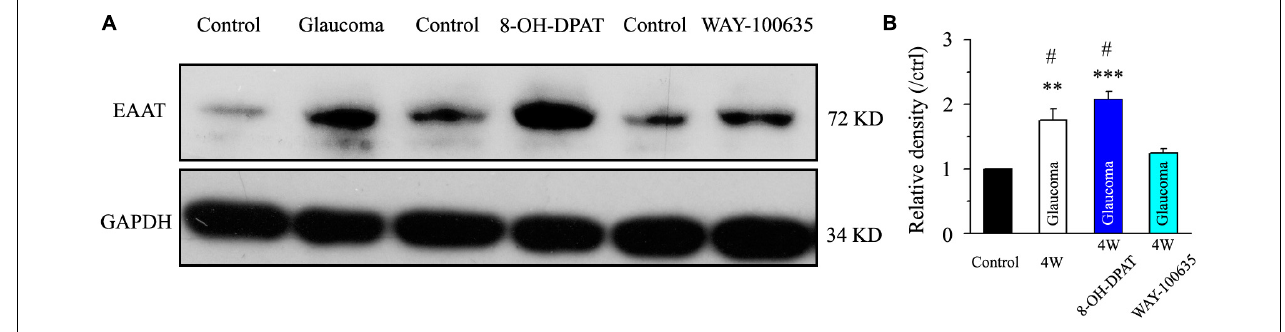
FIGURE 2 | Chronic ocular hypertension and 8-OH-DPAT upregulated EAAT2 expression in the rat retina, but this effect was reversed by WAY-100635. (A) Representative western blot of EAAT2 expression in control and glaucomatous retinas 4 weeks after EVC and in glaucoma 4W + 8-OH-DPAT retinas and glaucoma 4W + WAY-100635 retinas. The expression of the 72 kDa protein was increased in the glaucomatous retinas and in the glaucoma 4W + 8-OH-DPAT group. WAY-100635 downregulated EAAT2 expression 4 weeks after glaucoma induction. (B) Densitometric analysis of EAAT2 expression in the glaucoma 4W and drug intervention groups ( n = 7). EAAT2 expression was normalized to the expression in the control retinas. ANOVA, ∗∗ p < 0.01 and ∗∗∗ p < 0.001 vs. control retina, # p < 0.05 vs. glaucoma 4W + WAY-100635. W, week; EAAT, glutamate